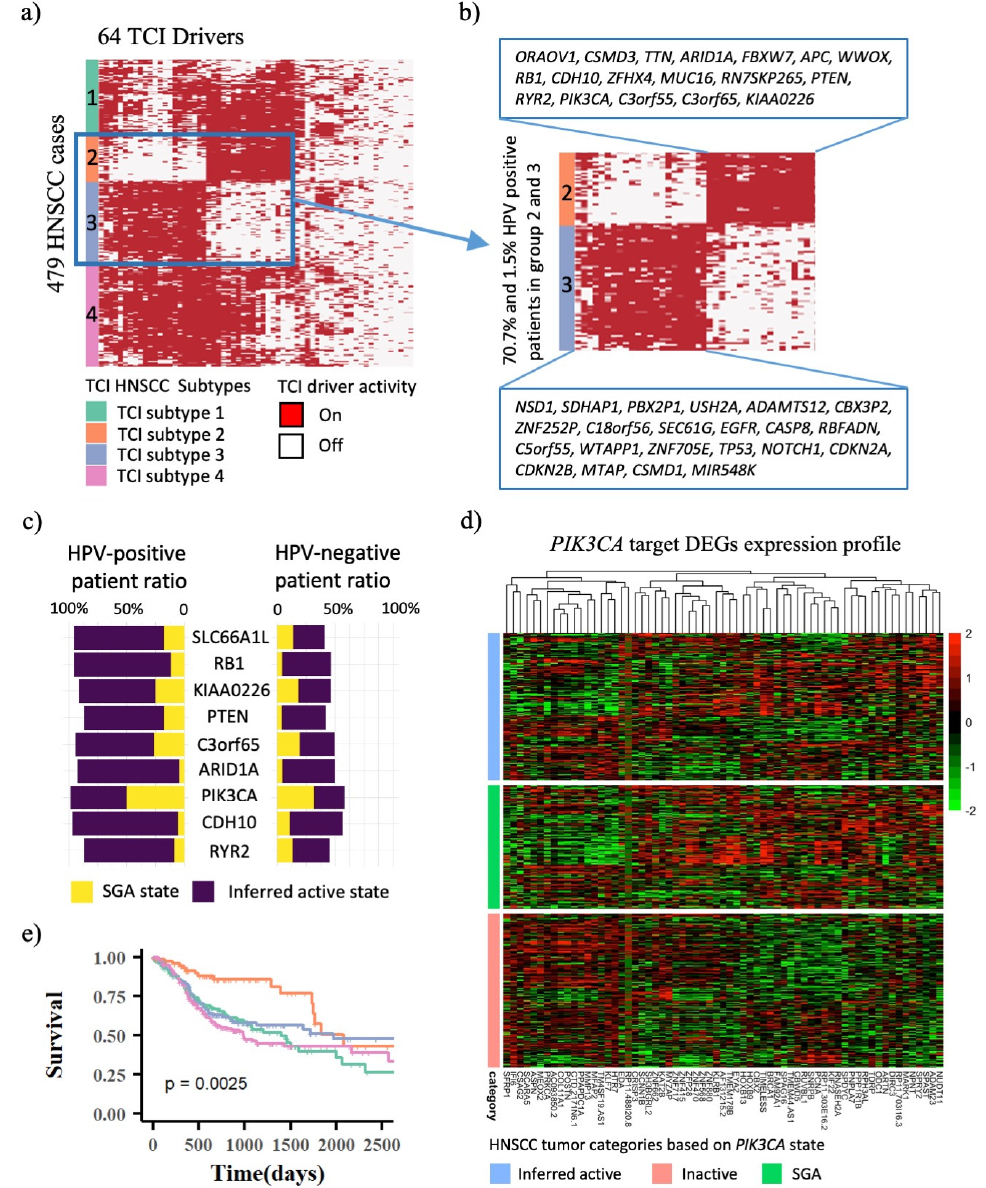
Figure 4. Clustering based on inferred protein states identified four subtypes and drivers found to be associated with HPV-positive patients. ( a ) Four subtypes of HNSCC samples were discovered based on EM inferred driver protein activation states, where red denotes inferred driver state is on and white denotes inferred driver state is off. ( b ) 70.7% of patients in subtype 2 are HPV-positive patients, while 1.5% of patients in subtype 3 are HPV-positive. Patients in subtype 2 and 3 are asso- ciated with different set of drivers. ( c ) Bar plot of drivers with higher inferred protein activation rate but similar SGA frequencies in HPV-positive than in HPV-negative patients, where yellow bar de- notes the SGA frequency and purple bar denote the inferred driver activation rate. ( d ) Expression profiles of TCI-derived PIK3CA targeted DEGs in three groups of patients, i.e., patients with PIK3CA SGA, patients with inferred PIK3CA inferred protein activity and patients without PIK3CA SGA or inferred protein activity. ( e ) Survival analysis of four HNSCC patients subtypes categorized using inferred driver activation states.